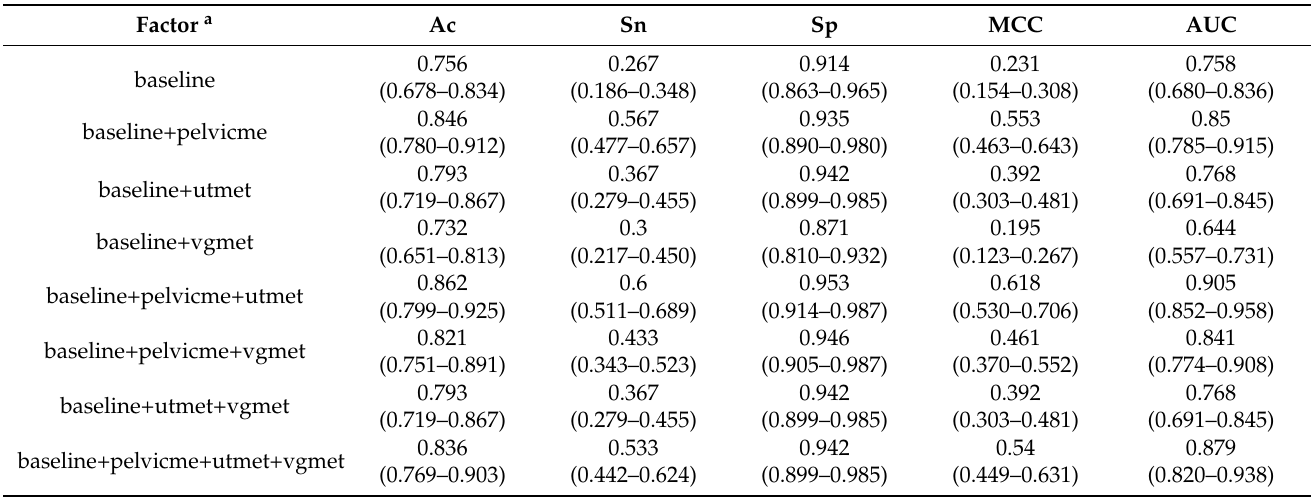
Table 2. Independent dataset testing results of RF models with various combinations of clinicopathological factors. Factor a Ac Sn Sp MCC